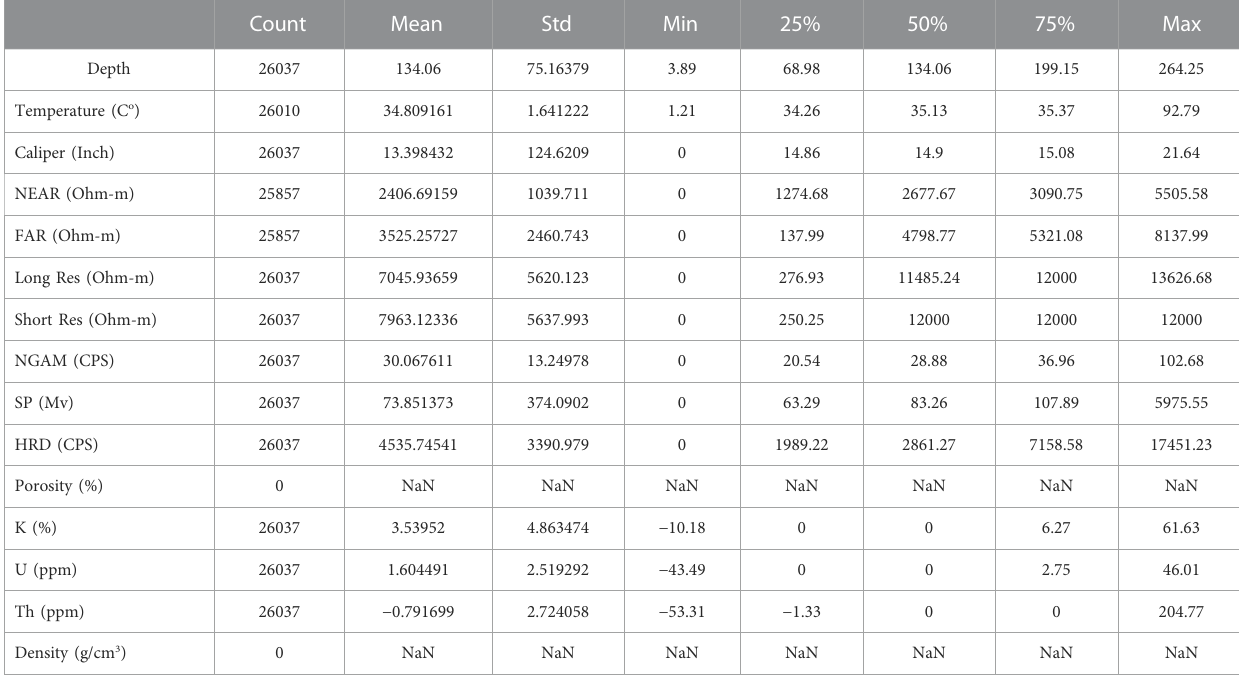
TABLE 3 Statistical analysis of log curve in well